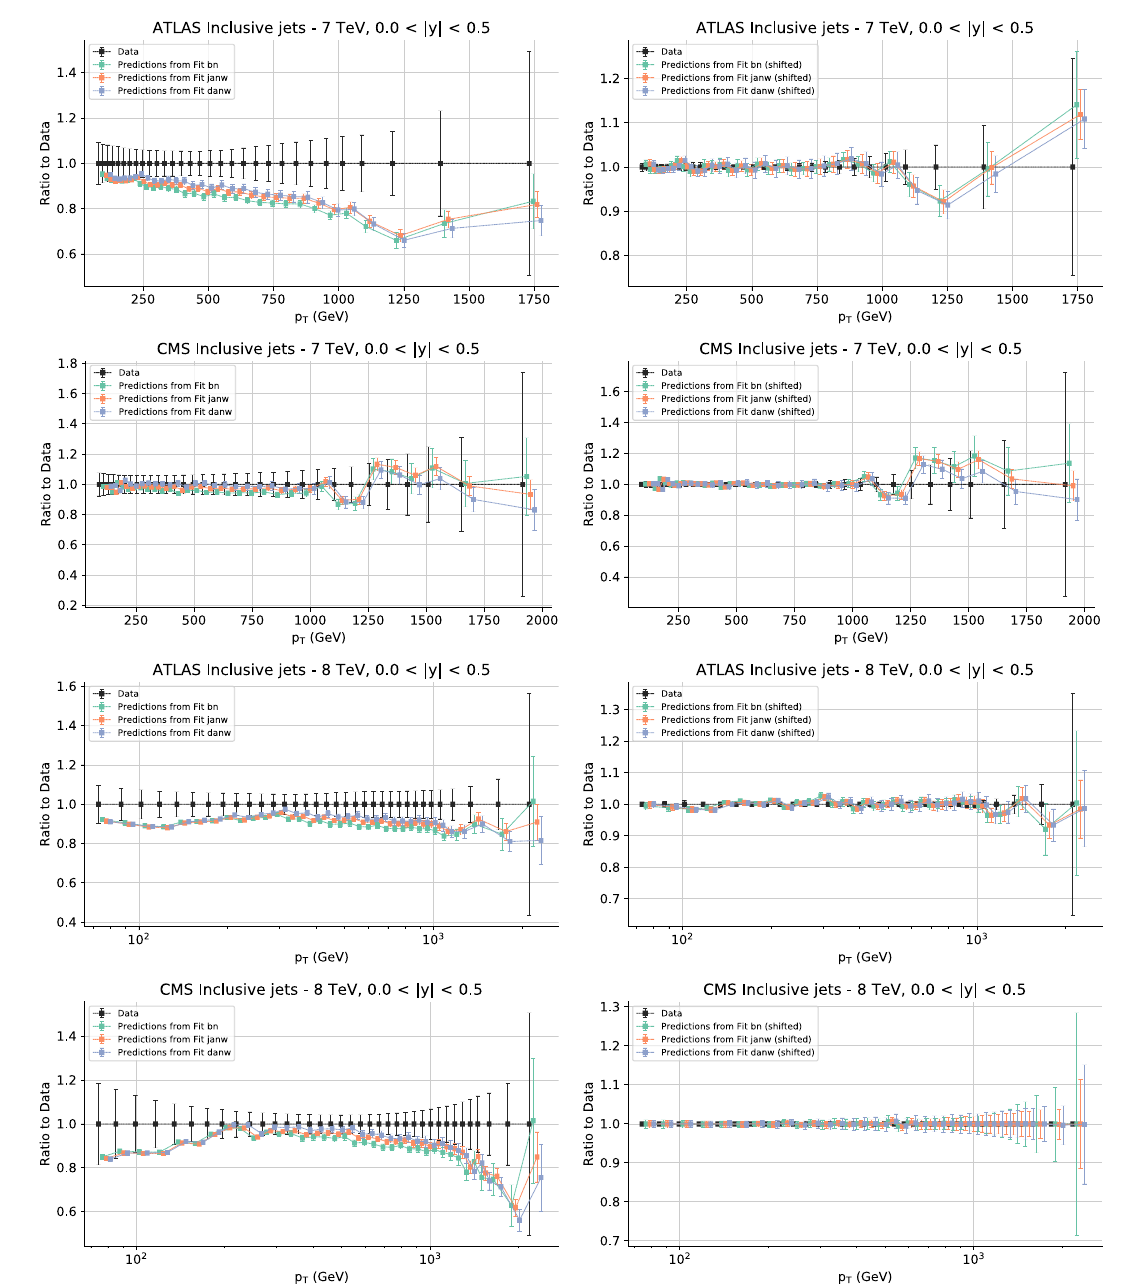
Fig. 18 The theory to data ratio for a representative set of points from each single-inclusive jet dataset introduced in Sect. 2. Specifically, we show the central rapidity bins for all the ATLAS and CMS jet datasets at 7 and 8 TeV. Theoretical predictions are computed from fits #bn, #janw